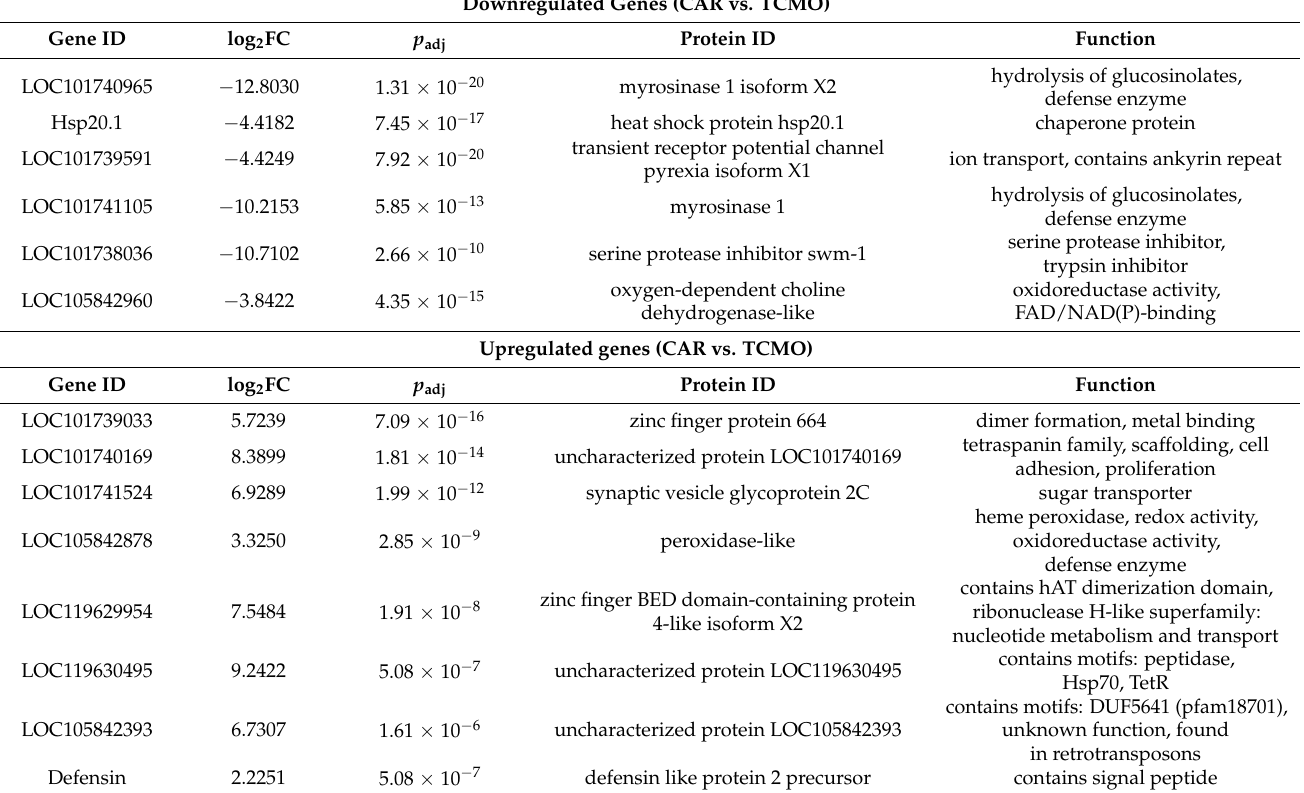
Table 6. Summary of select top DEGs between different Bombyx mori strains (CAR vs. TCMO).